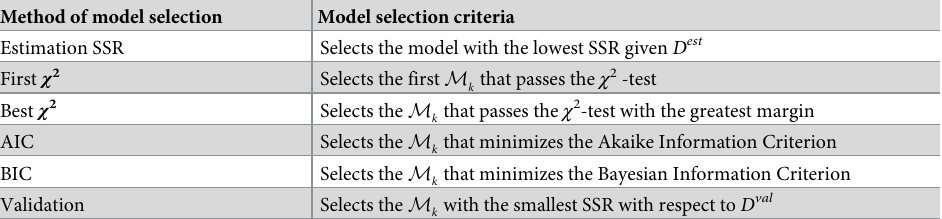
Method of model selection Model selection criteria Estimation